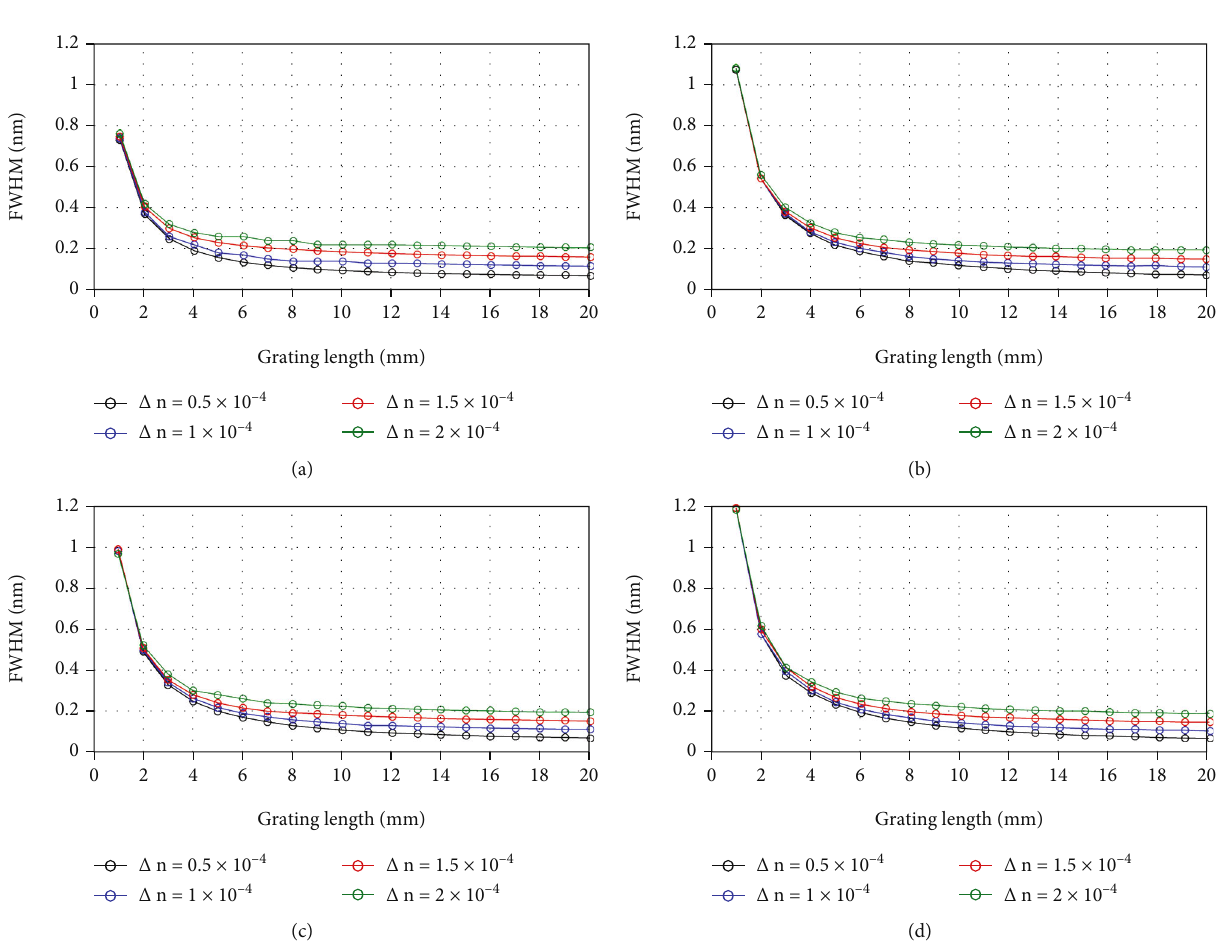
Figure 6: Re fl ectivity versus grating length of FBG with (a) uniform, (b) Gaussian apodization, (c) sine apodization, and (d) raised sine apodization.